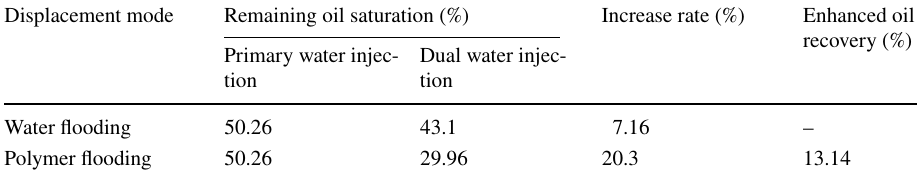
Displacement mode Remaining oil saturation (%)